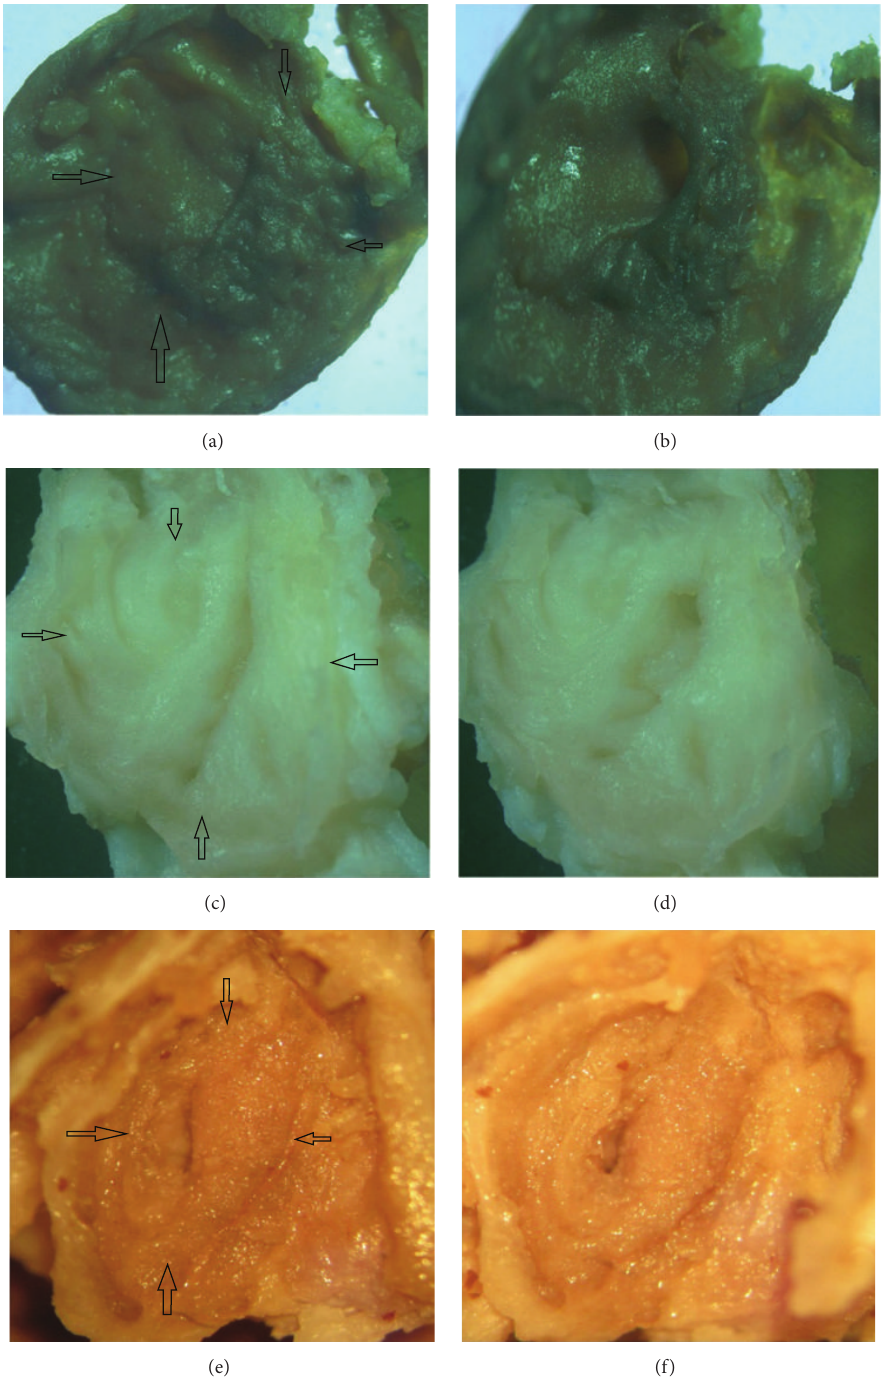
Figure 2: Orifice open/close under the relaxation/stretch of the muscles around the lacrimal sac. (a), (c), and (e) show that the orifices are closed when the related muscles are stretched. (b), (d), and (f) show that the orifices are opened when the muscles are relaxed. It should be noted that there is always a circle area (arrows) around an